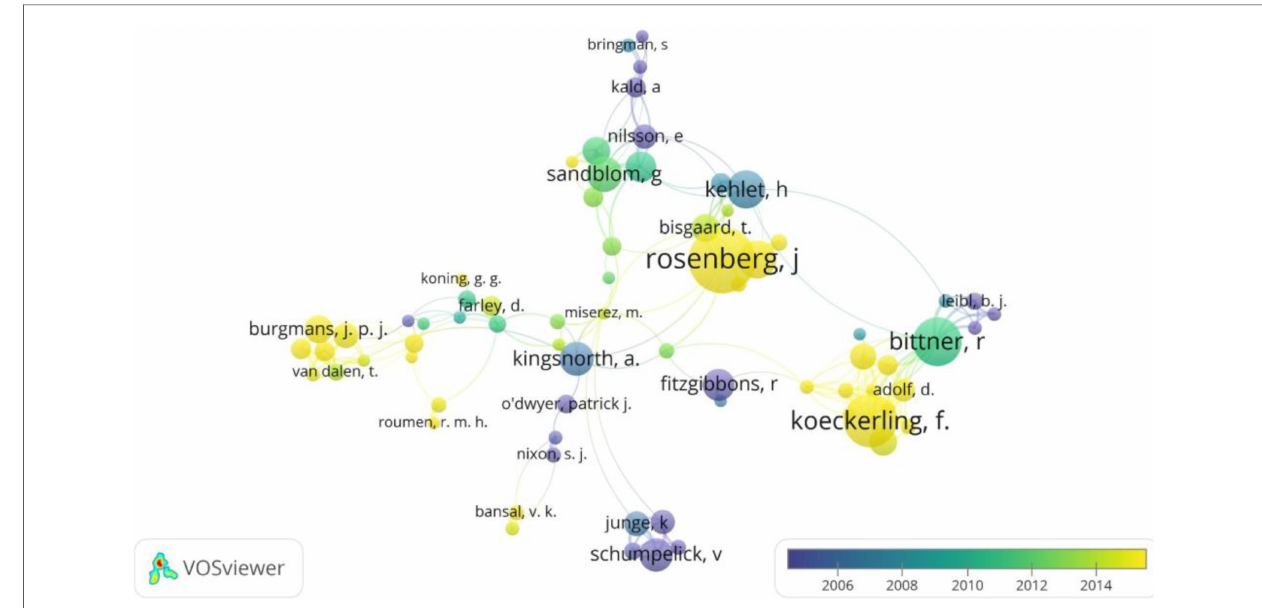
FIGURE 2 Bibliographic coupling network of authors with the greatest number of articles published in the web of science